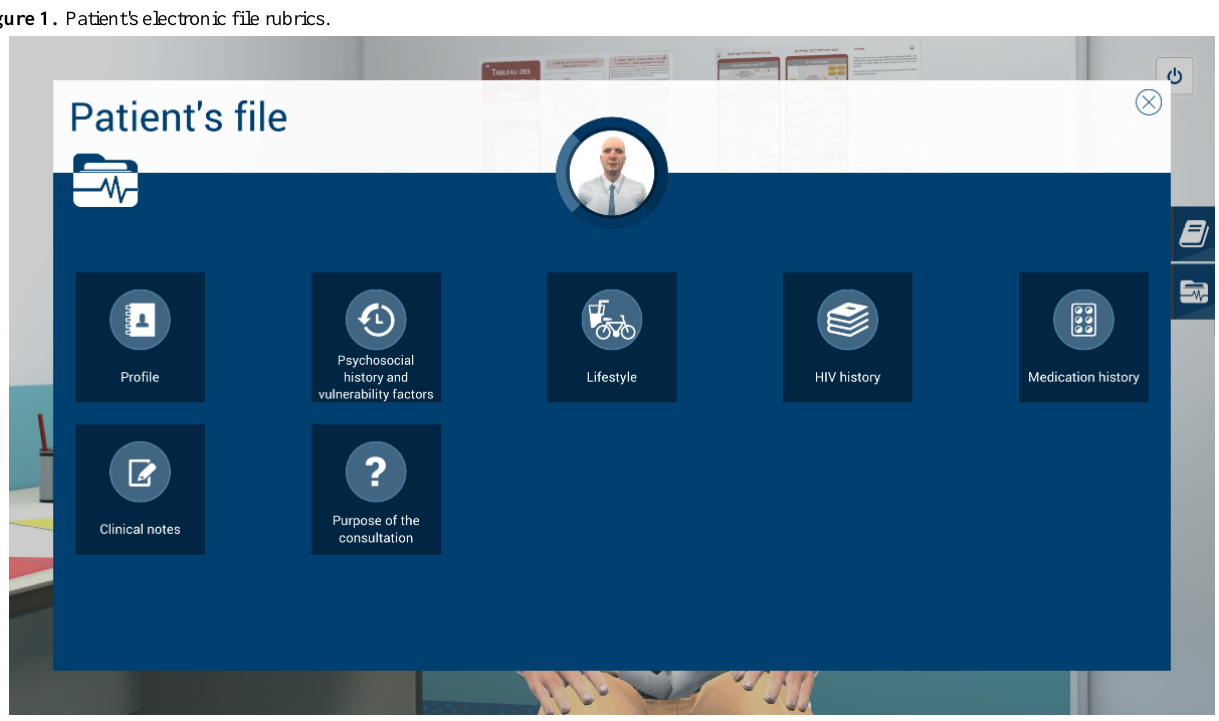
Figure 1. Patient's electronic file